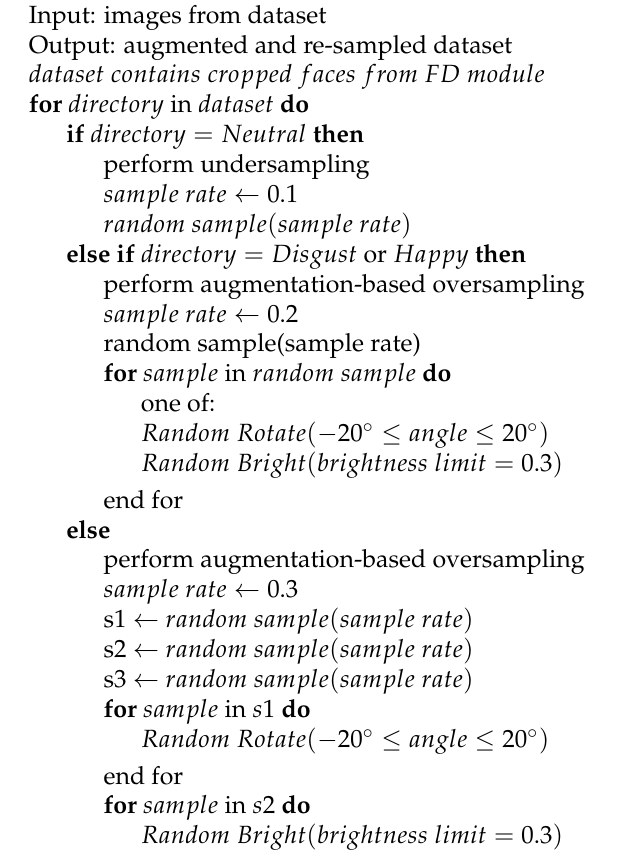
Algorithm 1 Augmentation-based re-sampling